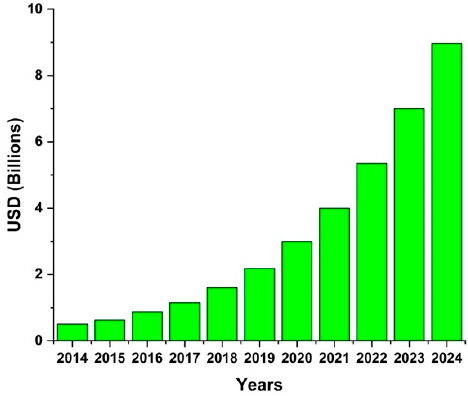
Figure 1. Smart textile market (Data source: Ameri Research Inc. [6]).